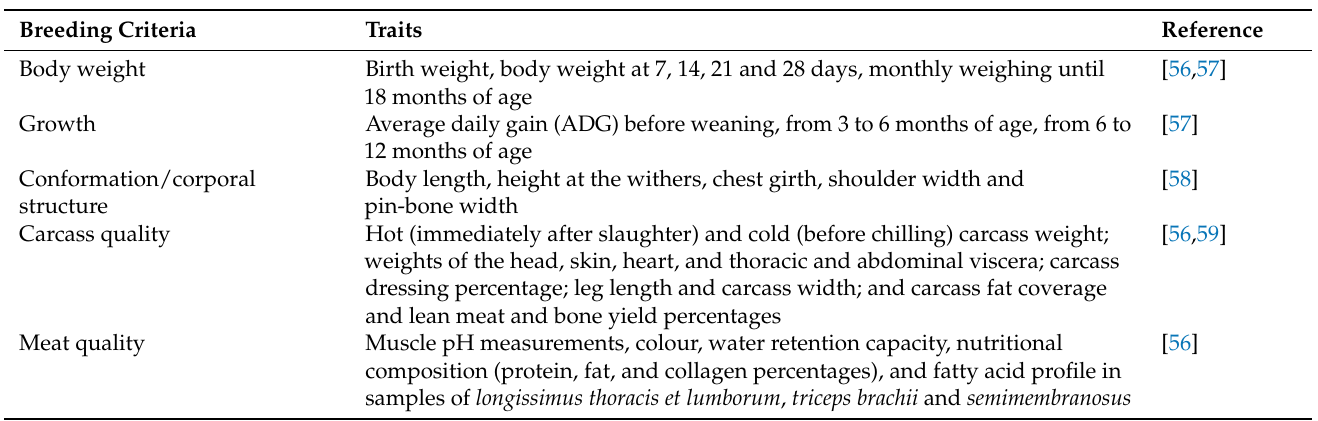
Figure 3. Summary scheme of caprine candidate genes’ influence on meat production. Table 1. Breeding criteria and traits for caprine meat